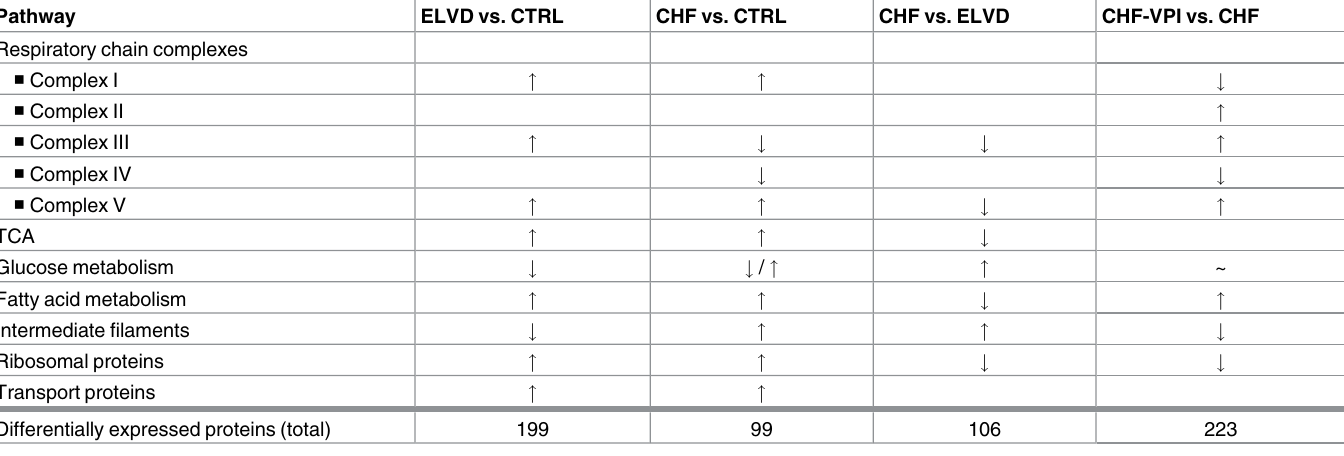
Table 2. Synopsis of different pathway regulation patterns. Pathway ELVD vs. CTRL CHF vs. CTRL CHF vs. ELVD CHF-VPI vs.